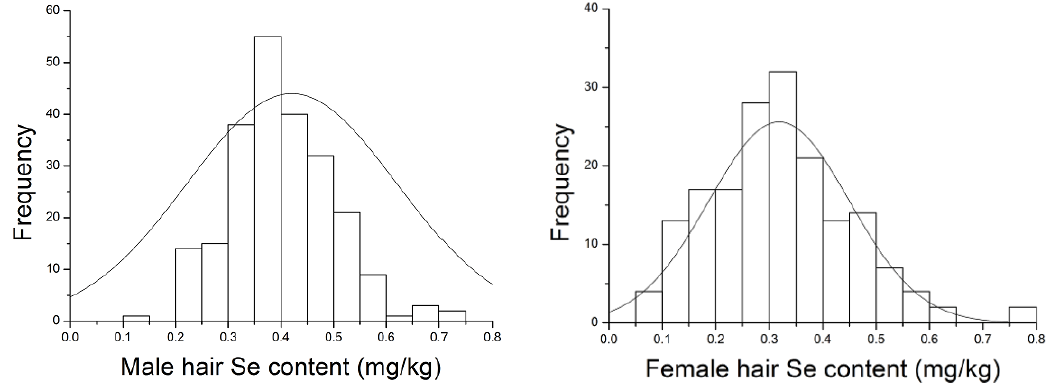
Figure 3. The statistical distribution of hair Se content in males and